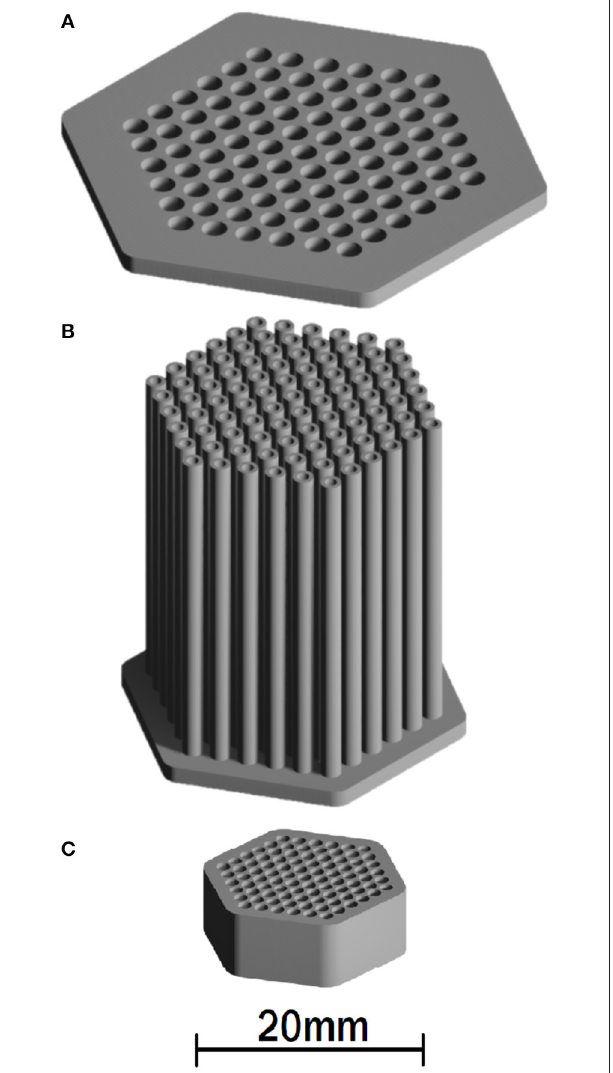
FIGURE 9 | CAD-models of the 3D-printed parts of prototype 2 with 91 tubes. (A) The movable grid. (B) Tubes and base plate in one part. (C) Scaffold for the fibers at the image side. The tubes have slightly different lengths, i.e., longer in the center, so that the angles α in each facet are the same, considering the equal lengths of the